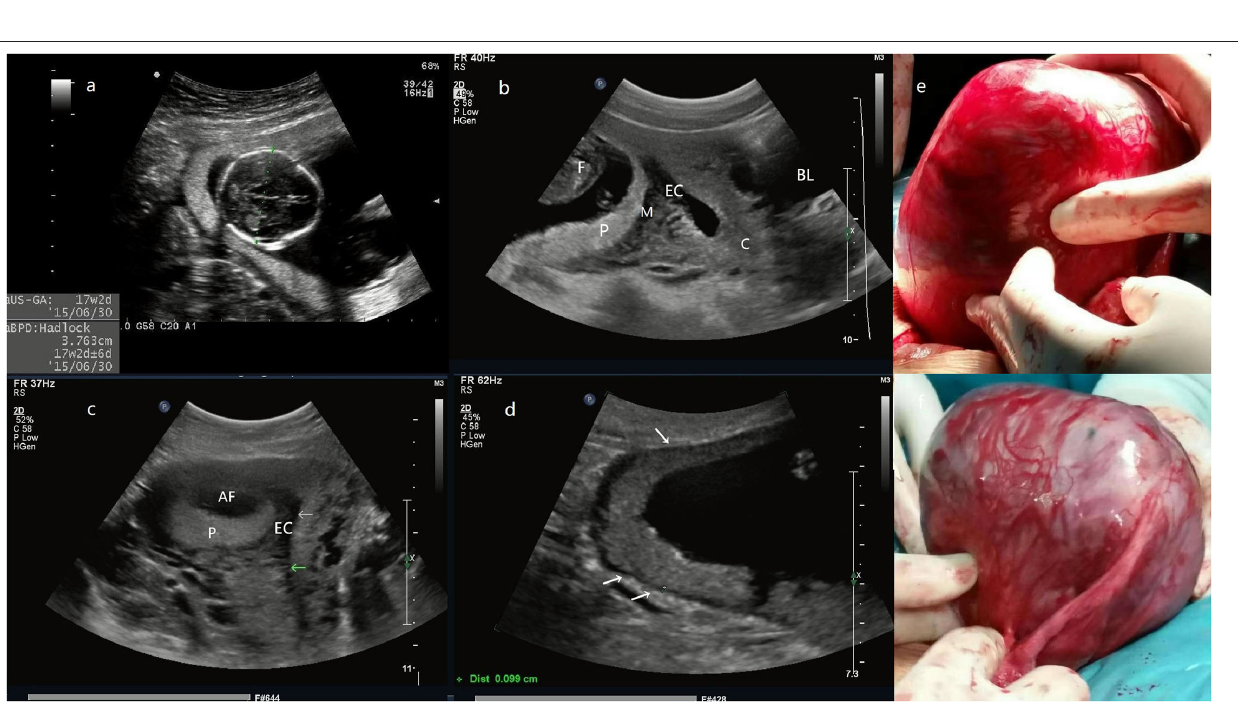
FIGURE 1 | (a) the biparietal diameter of the fetus is 38mm, the estimated gestational age is 17 weeks and 2 days. (b) The midsagittal section image reveals that the posterior myometrium is between GS and the EC. (c) The transversal section shows that the GS is located in the right posterior wall with a myometrial echo between GS and the EC (arrow). (d) The site of placental attachment covers the entire right posterior wall of the uterus, with a myometrial thickness of 0.9–1.2mm (arrow). (e) The intraoperative image, an enlarged uterus with a thin wall mass (a size of 14cm) protrudes at the right posterior wall of the fundus, the fetus, and fetal movement